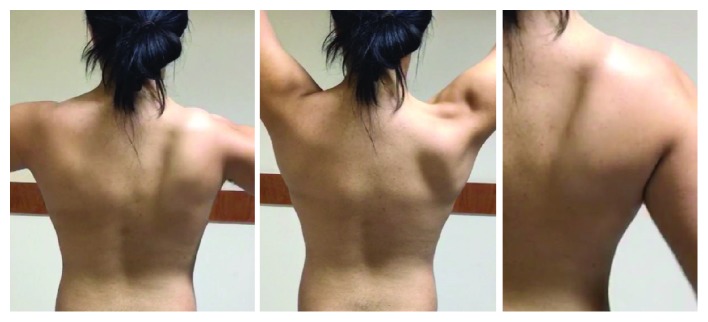
Scapular dyskinesis.